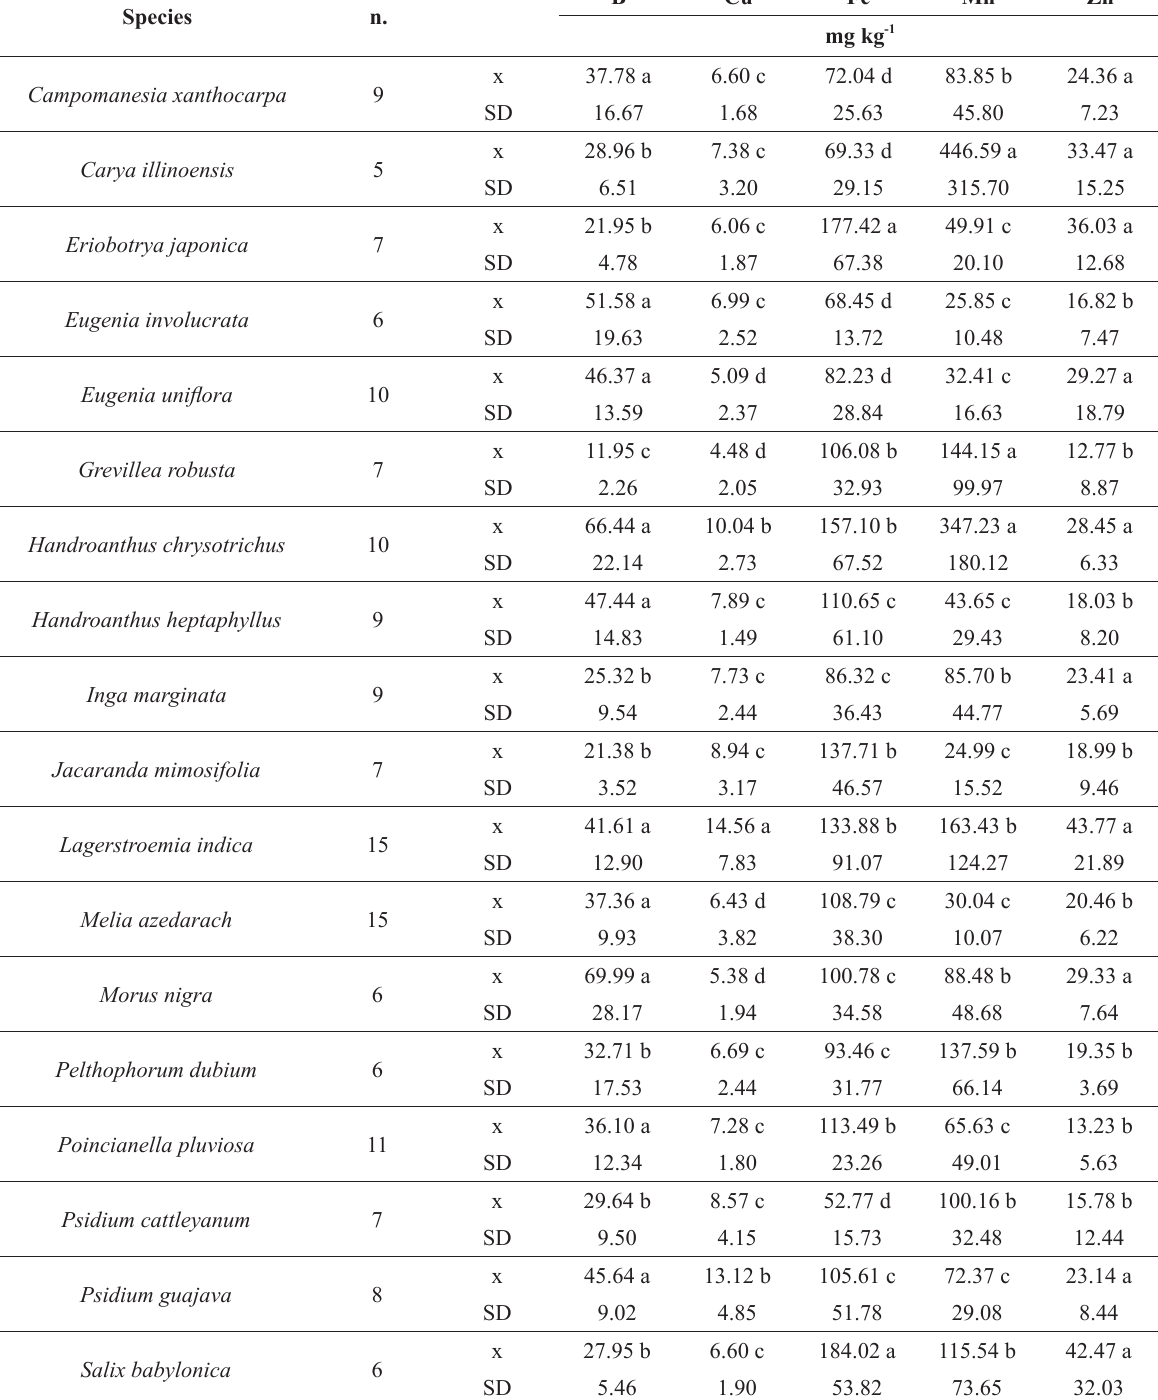
Number of trees (n), mean (x) and standard deviation (SD) of the foliar concentrations of micronutrients in tree species utilized in street afforestation – Rio Grande do Sul State –